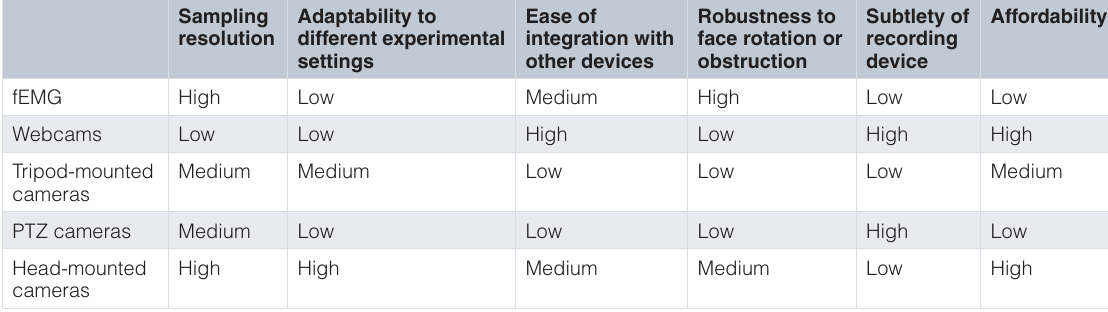
Table 1. Relative comparison of facial expression recording